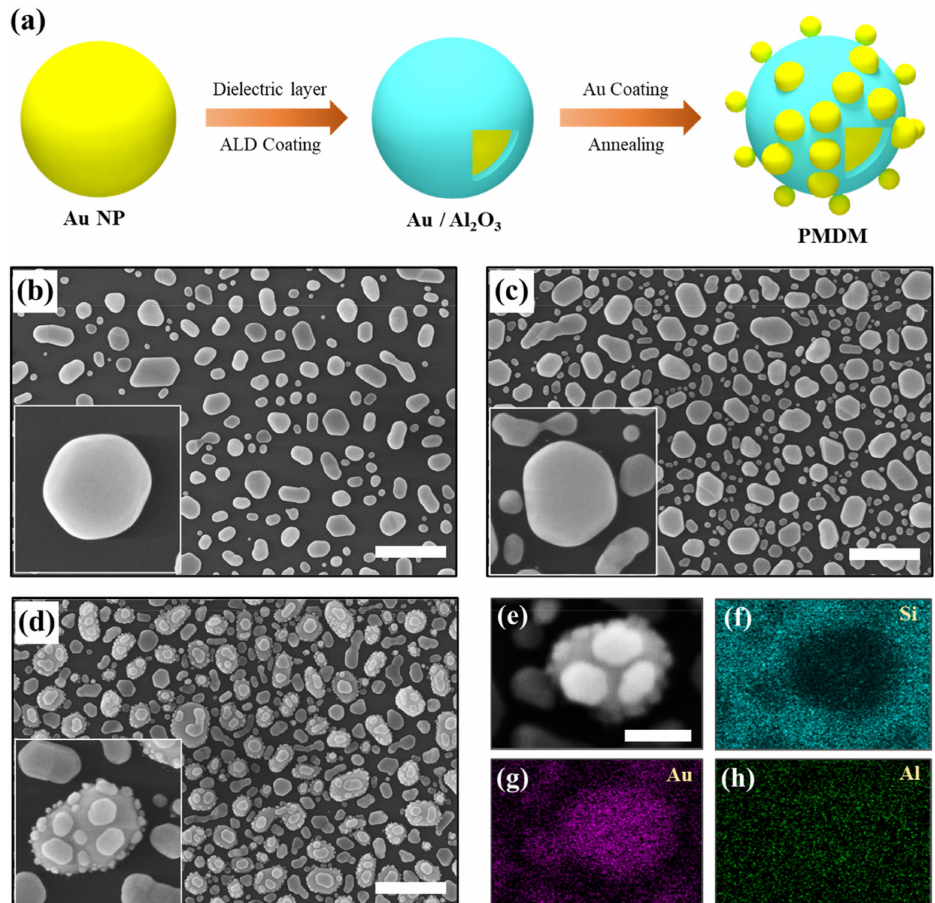
Figure 1. ( a ) Schematic illustration of the fabrication of hierarchically assembled plasmonic metal- dielectric-metal (PMDM) nano-architectures. ( b ) SEM image of Au nanoparticles (NPs) fabricated on Si/SiO 2 substrate by the annealing of Au film (10 nm) at 800 ◦ C for 120 s. ( c ) Fabrication of double dewetting Au NPs arrays grown on Au NPs (Au/Au) by the deposition of 5 nm Au film and subsequent annealing at 450 ◦ C for 120 s. ( d ) SEM image of hierarchically assembled PMDM hybrid nano-architectures. Scale bar: 400 nm. ( e – h ) EDS mapping of PMDM hybrid nanostructures